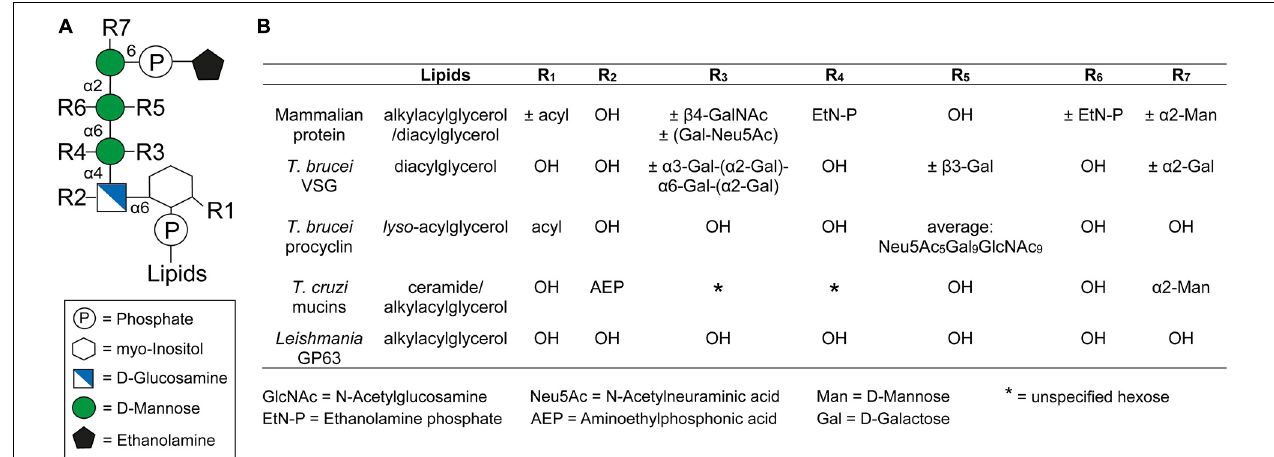
FIGURE 1 | General structure of the GPI anchor and their side chain modifications. (A) Structure of the conserved glycan core with the different side chain modifications. The respective positions of the modifications are indicated by R x . (B) Comparison of different side chain modifications ( R x ) and lipid moieties for selected GPI anchored proteins in mammals, Trypanosoma brucei , Trypanosoma cruzi, and Leishmania . The positions of R1-7 and the lipids in the GPI anchor are indicated in panel (A) . The nature and position of linkage of an additional hexose (*) at the first mannose of the GPI anchor of T. cruzi mucins is not yet known (Serrano et al., 1995). This figure was modified from Figure 1 of a review by Fujita and Kinoshita